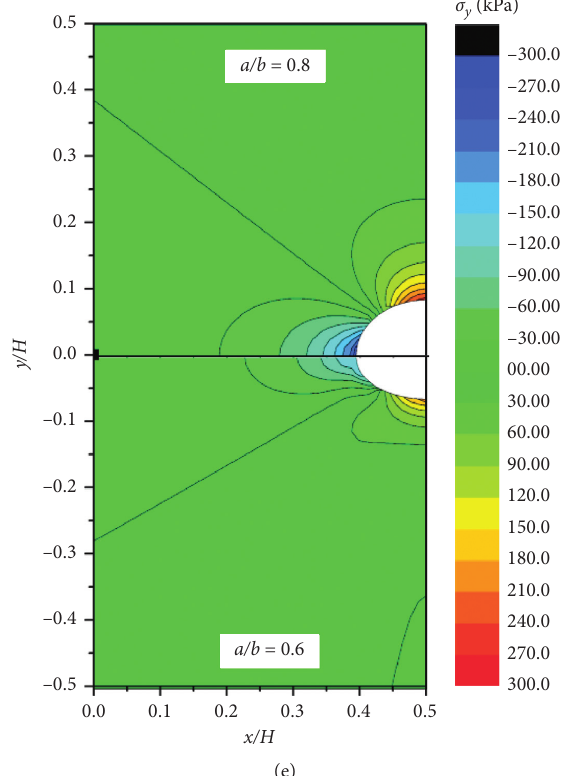
Figure 8: Contours of the normalized stresses and displacements in the case of the elliptical tunnel with different ellipticity values. (a) Shearing stress of soil. (b) Soil stress in the x -direction. (c) Soil displacement in the x -direction. (d) Soil displacement in the y -direction. (e) Soil stress in the y